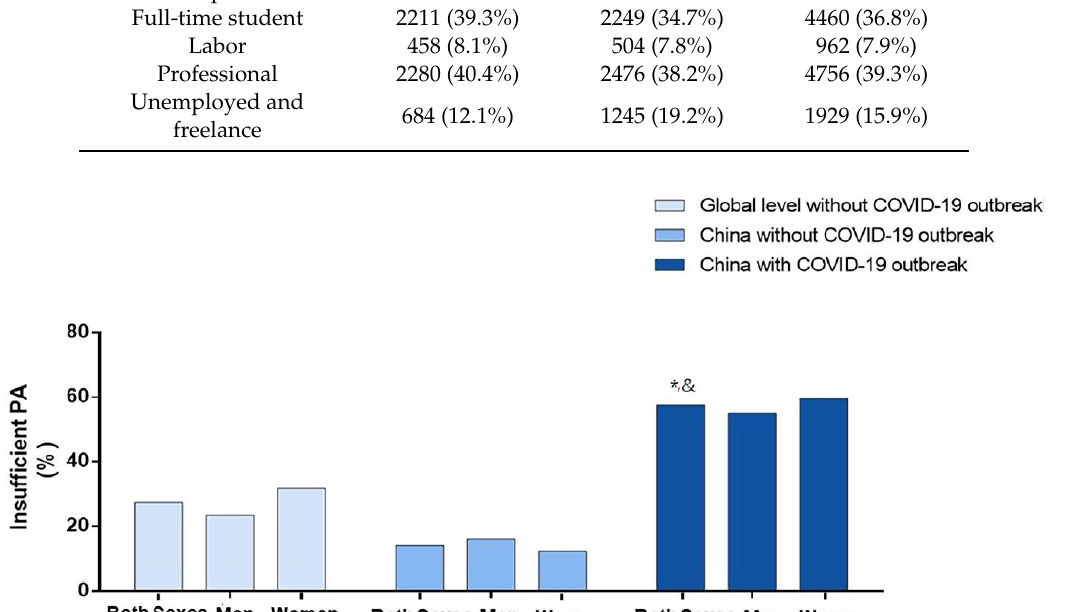
Figure 1. Prevalence of insu ffi cient physical activity (PA) among Chinese adults aged 18 and over during COVID-19 epidemic period in China, compared with the national levels in China (during non-epidemic period) and the average global level (World Health Organization (WHO) data, without COVID-19 outbreak), among all participants, men, and women, separately. PA = physical activity. * p < 0.05 versus Global level; & p < 0.05 versus China without COVID-19 outbreak (non-epidemic